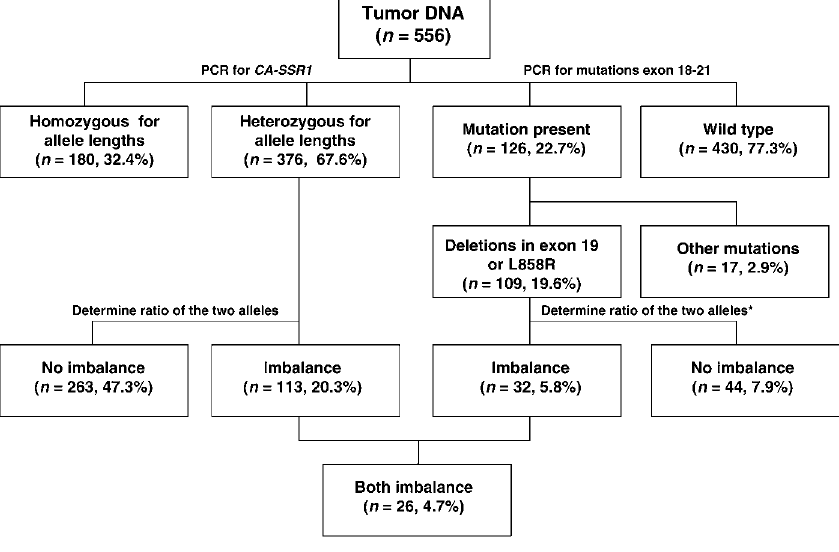
Figure 4. Flow Chart for Examination of the Relationship between AIs of CA-SSR1 Length and EGFR Mutations